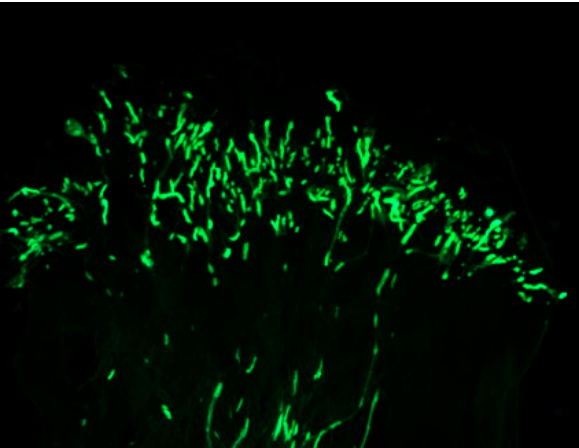
Fig 1. Florescence microscopy photographed from pollens of Red delicious germinated on the Golden delicious stigma and pollen tubes penetrated to the upper part of the